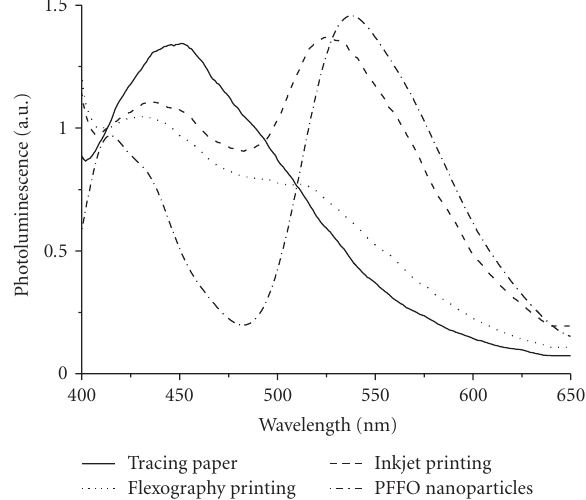
Figure 5: Photoluminescence of full tone printed patterns and PFFO nanoparticles